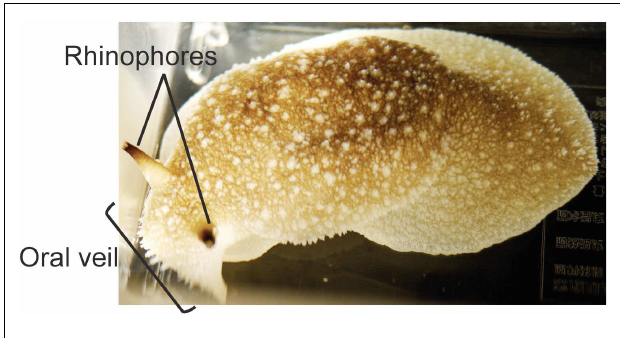
FIGURE 1 |A Pleurobranchaea with chemotactile oral veil and rhinophores indicated.